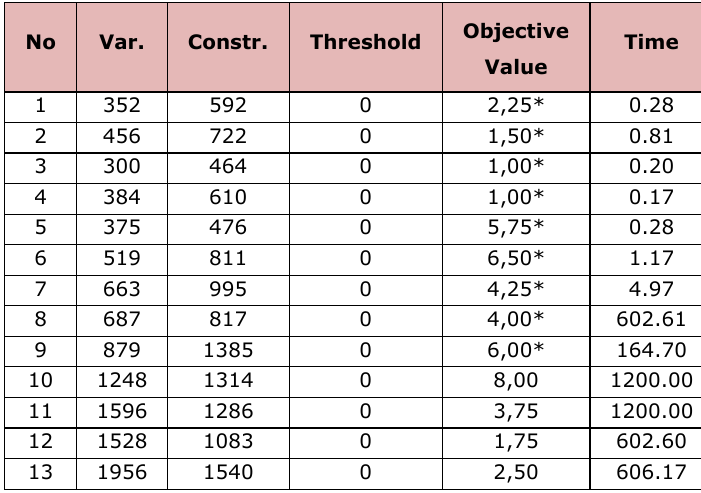
Table 4. “Obtained results by the scheduling model”. Source: